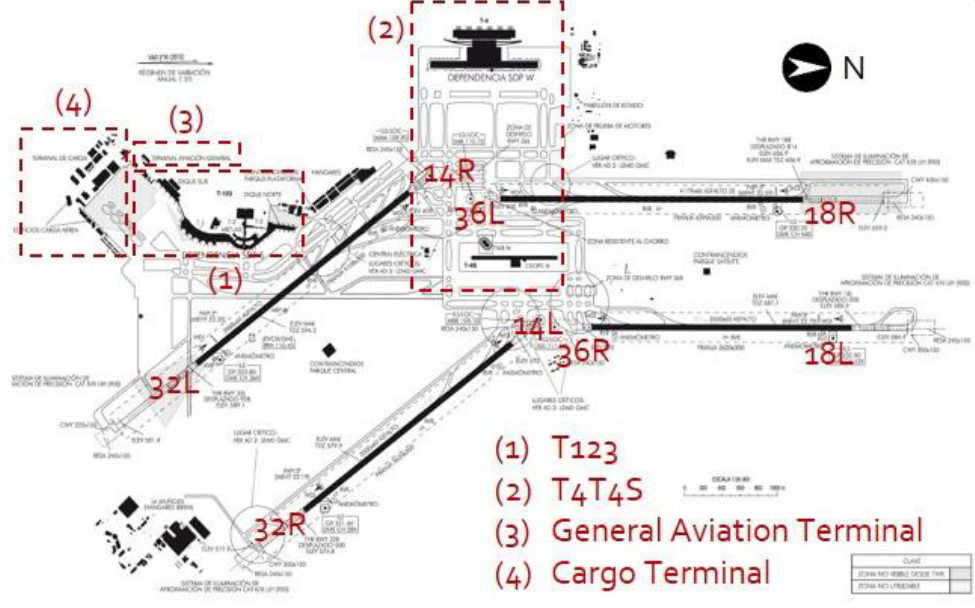
Figure 6. Functional structure of Madrid airport (LEMD). Adapted from [81].